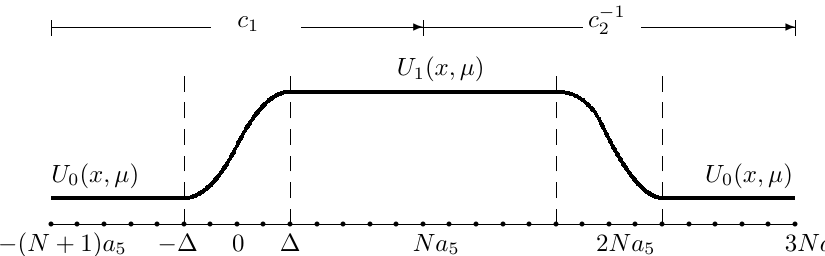
Figure 3 . Pauli-Villars spinor-boson with a (cid:12)ve-dimensional link (cid:12)eld representing a closed loop c c (cid:0) 1 in the space of link 1 2